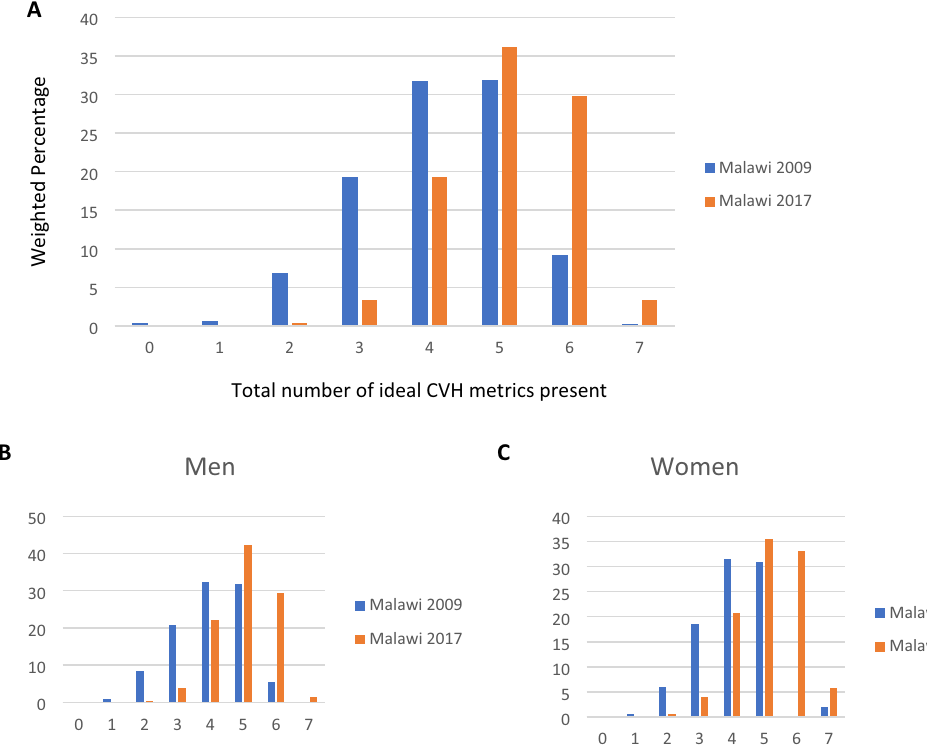
Figure 2. Distribution of the total number of ideal CVH metrics present in Malawi from 2009 to 2017 in the general population ( A ) and according to sex ( B , C